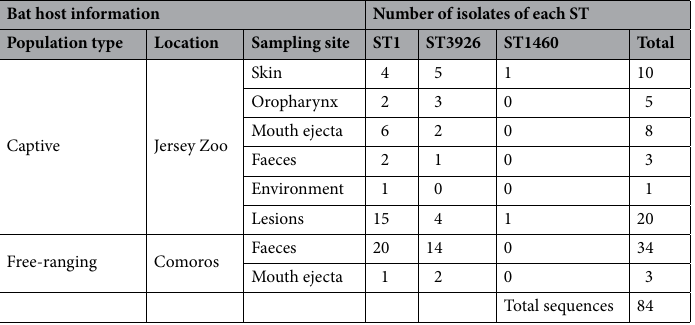
Table 1. Staphylococcus aureus genomes sequenced from captive Livingstone’s fruit bats in Jersey Zoo and free-ranging in Mohéli, Comoros Republic. Number of sequence types (ST) acquired from each population and sample